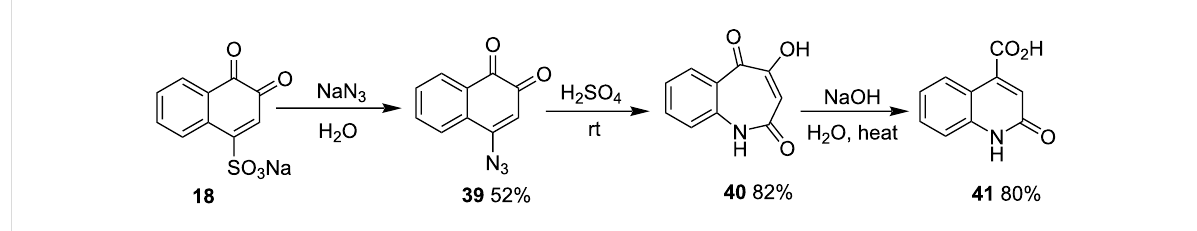
Scheme 11: Reactions of 4-azido-1,2-naphthoquinone.